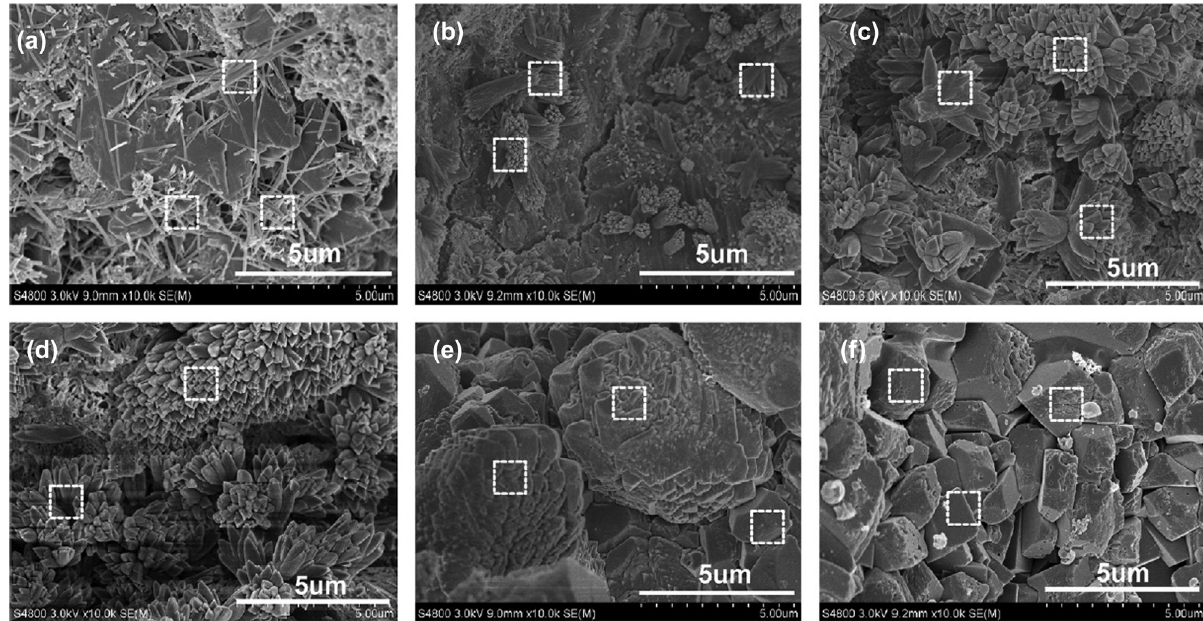
Figure 14: SEM images of cement composites at 28 days mixed with GO: ( a ) no GO; ( b ) GO 0.01%; ( c ) 0.02%; ( d ) 0.03%; ( e ) 0.04%; and ( f ) 0.05% [ 79 ]